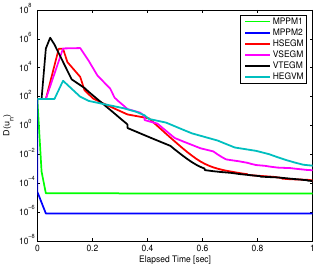
Figure 5. Methods for Example 2 with α n = ( n + 1) − 0 . 5 . Number of iterations is 61, 70, 118, 164, 212, 239,